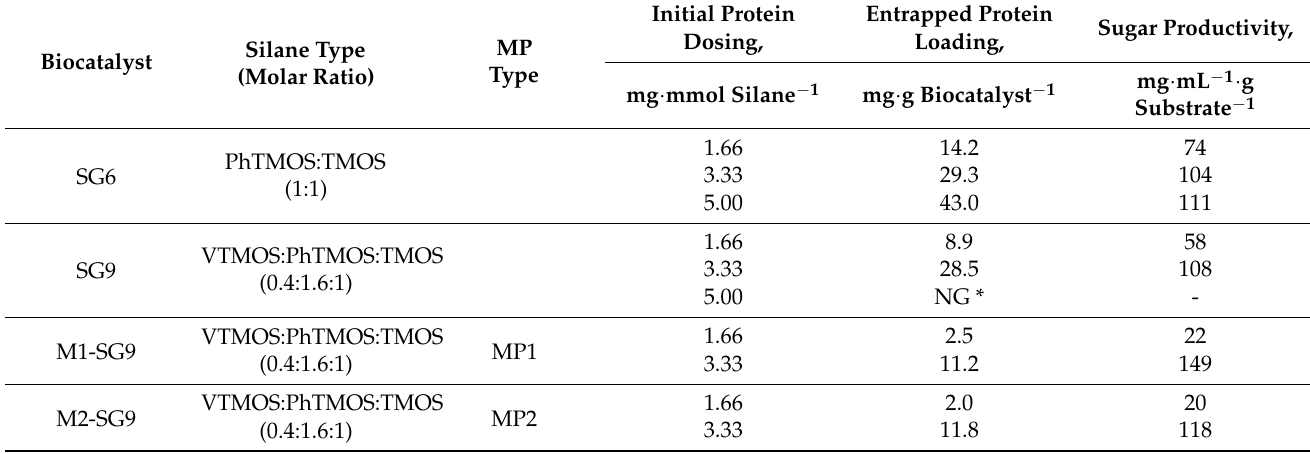
Table 5. Influence of protein loading on the enzymatic hydrolysis of microcrystalline cellulose Av- icel-PH101, at 24 h reaction time and 50 °C, as catalyzed by immobilized biocatalysts which were obtained by their entrapment in sol–gel and magnetic sol–gel.